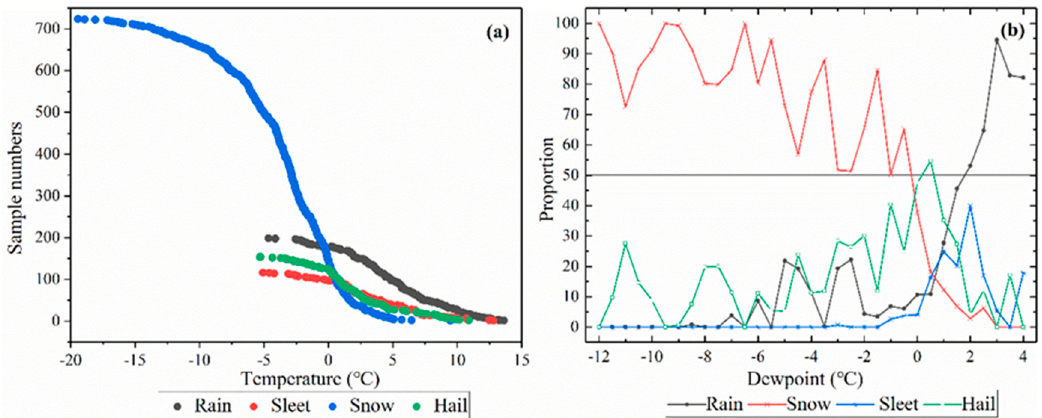
Figure 9. ( a ) Relationship between temperature and the occurrence of rain, sleet, snow, and hail at Tanggula. ( b ) Relationship between the dewpoint and the proportion of rain, sleet, snow, and hail in precipitation at Tanggula.